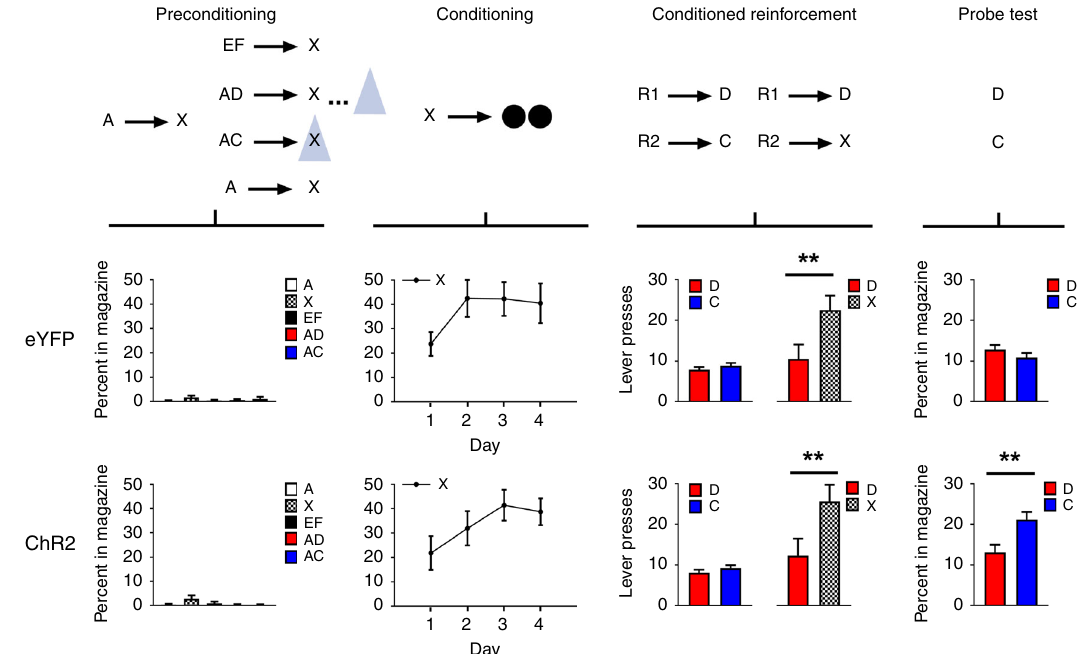
Fig. 2 Brief optogenetic stimulation of dopamine neurons in the VTA produces learned associations without endowing cues with cached value. Top row: Schematic illustrating the task design, which consisted of preconditioning and conditioning, followed by conditioned reinforcement and probe testing. A and E indicate visual cues, while C, D, F and X indicate auditory cues. R1 and R2 indicate differently positioned levers, and black circles show delivery of food pellets. VTA dopamine neurons were activated by light delivery in our ChR2 experiment group ( n = 8) but not in our eYFP control group ( n = 8), illustrated by the blue triangle, for 1 s at the beginning of X on AC trials and in the inter-trial interval on AD trials. Middle and bottom rows: Plots show rates of responding (with standard error of the mean represented above and below the mean; ± SEM) across each phase of training, aligned to the above schematic. The top row of plots show data for the eYFP control group and bottom row of plots show data for the ChR2 experimental group. For individual rats ’ responses see Supplementary Fig.